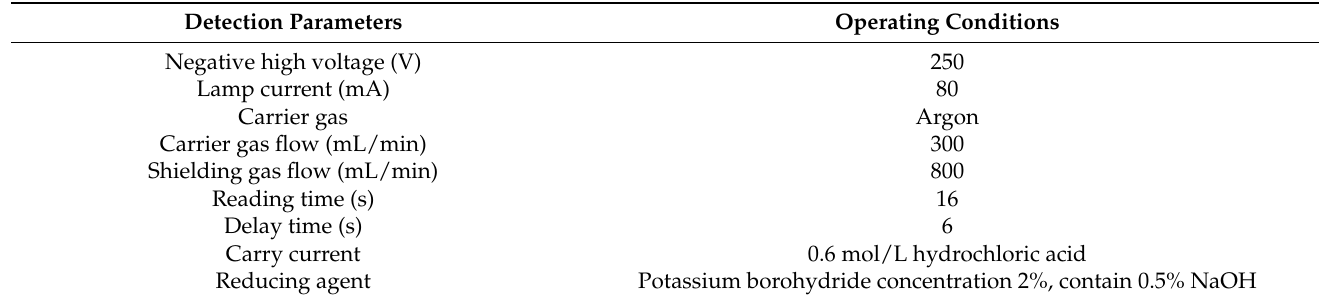
Table 5. Hydride Generation-Atomic Fluorescence Spectrometer Detection Conditions.